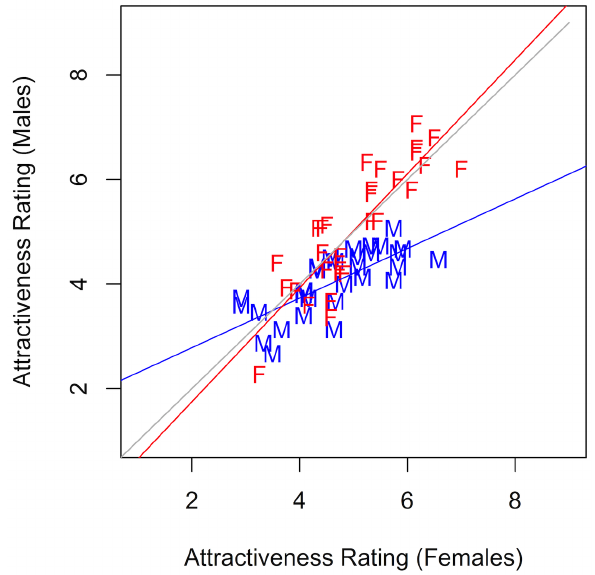
Figure 1. Correlations between Male and Female raters for Male (M, in blue) and Female (F, in red) voices.